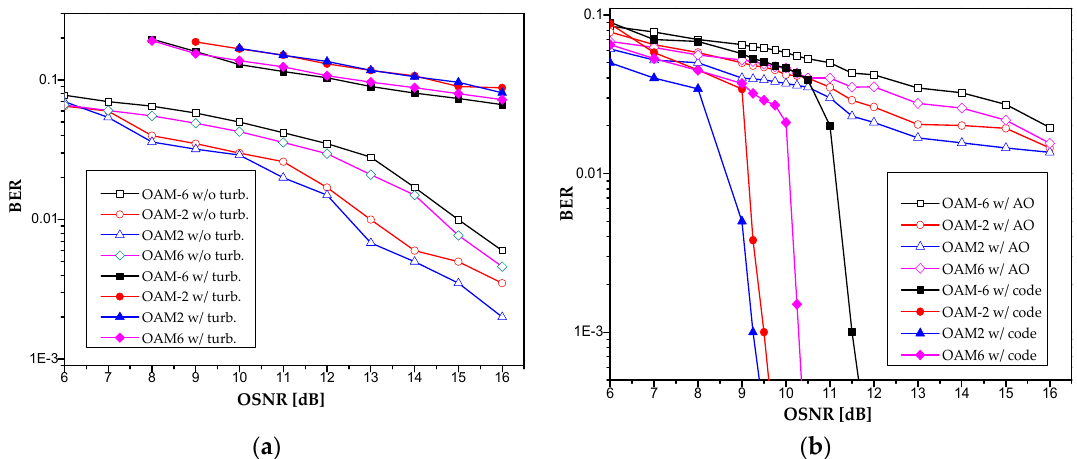
Figure 3. ( a ) Average BER vs. OSNR performance in cases with or without atmospheric turbulence effects. ( b ) Average BER vs. OSNR performance after AO assisted wavefront correction and low-density parity-check ( LDPC) coding.